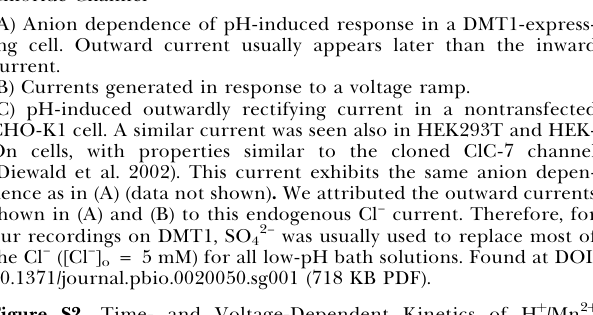
Figure S3. Na þ -Dependence of DMT1 H þ and H þ /Mn 2 þ Currents Replacement of extracellular Na þ by NMDG þ slightly increased the proton current (approximately 20%) and this was further augmented by adding 300 l M Mn 2 þ . The concentrations used were Na þ and NMDG þ , 140 mM, (pH 4.2); Mn 2 þ , 300 l M. Found at DOI: